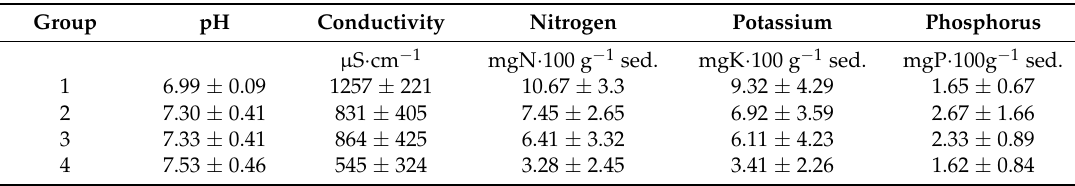
Figure 6. Principal component analysis for selected chemical sediment parameters of the studied lakes with regard to the groups of lake overgrowth. Table 4. Variability in the selected chemical parameters of sediments in the analyzed group of lakes overgrowth (mean ±